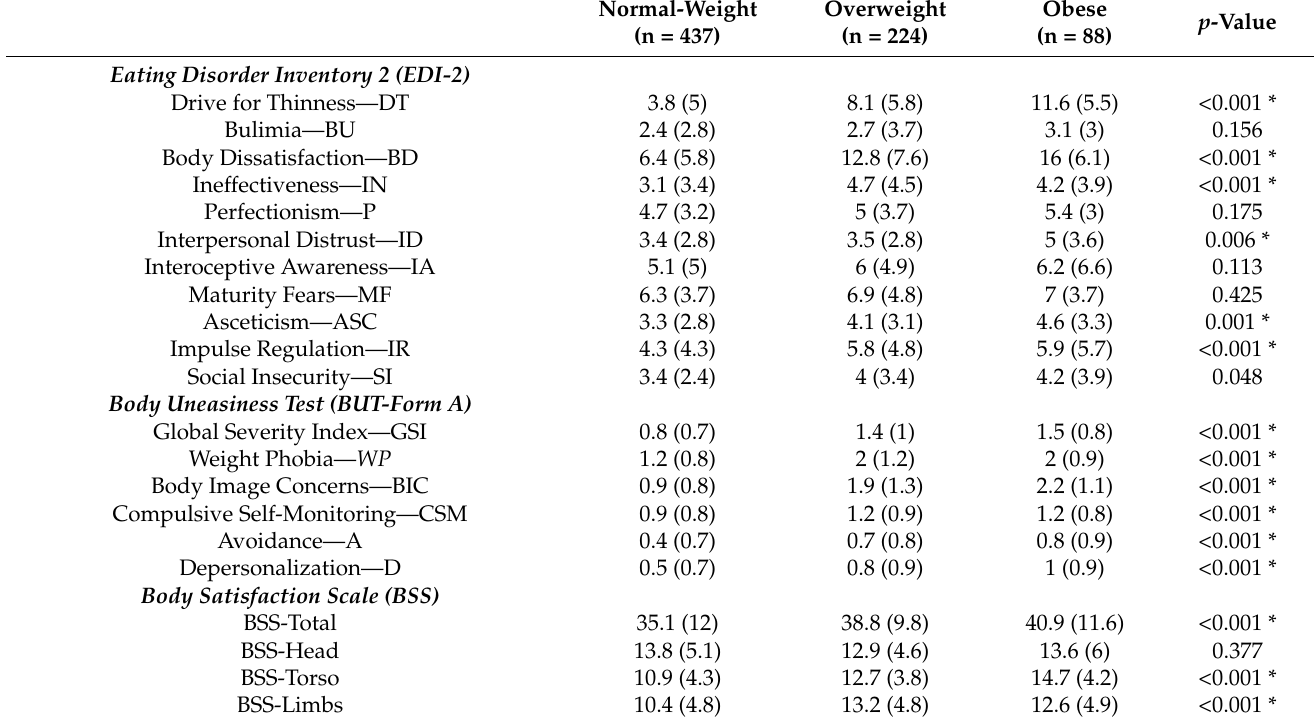
Table 1. Mean raw scores (SDs) for each